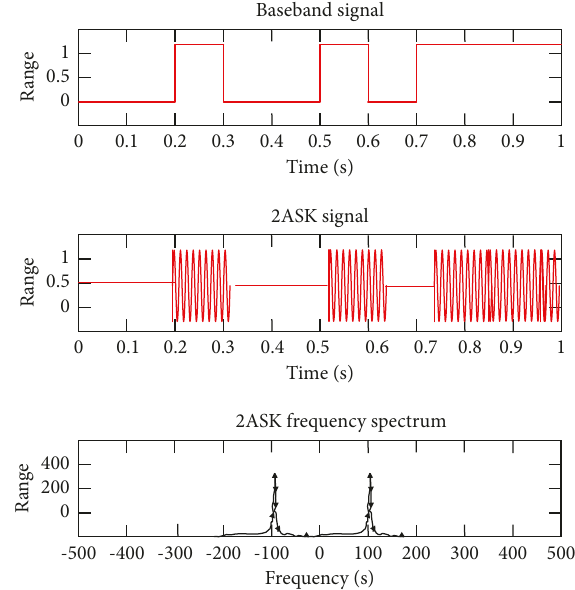
Figure 1: 2ASK time-domain waveform and spectrum.